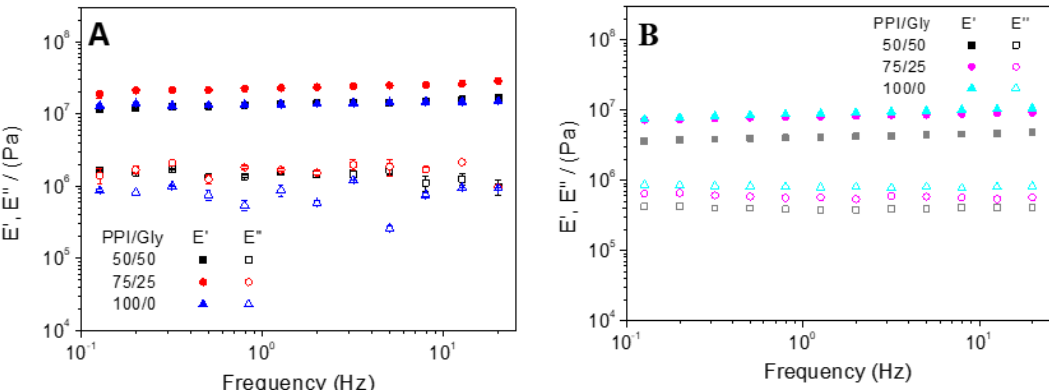
Figure 6. Frequency sweep tests for porcine plasma protein (PPP) − based materials plasticized with glycerol (Gly) with different PPP/Gly ratios, 50/50, 75/25, and 100/0, dried after swelling with two different methods: ( A ) natural convection oven at 50 °C and ( B ) freeze-drying.